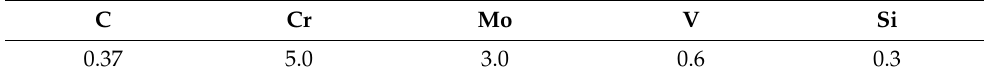
Table A1. Chemical composition of H10 tool steel (DIN 1.2367) in mass % [22].